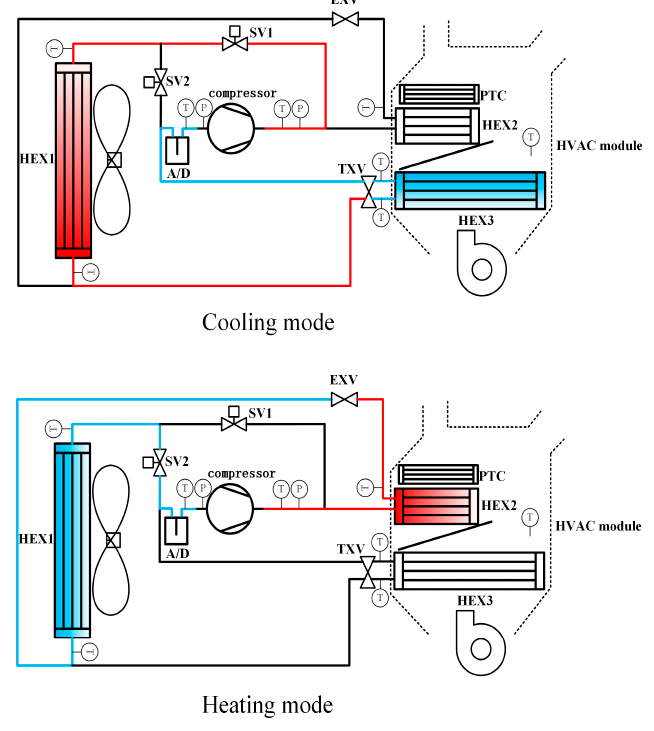
Figure 1. The schematic of an air-conditioning heat pump (ACHP) system.